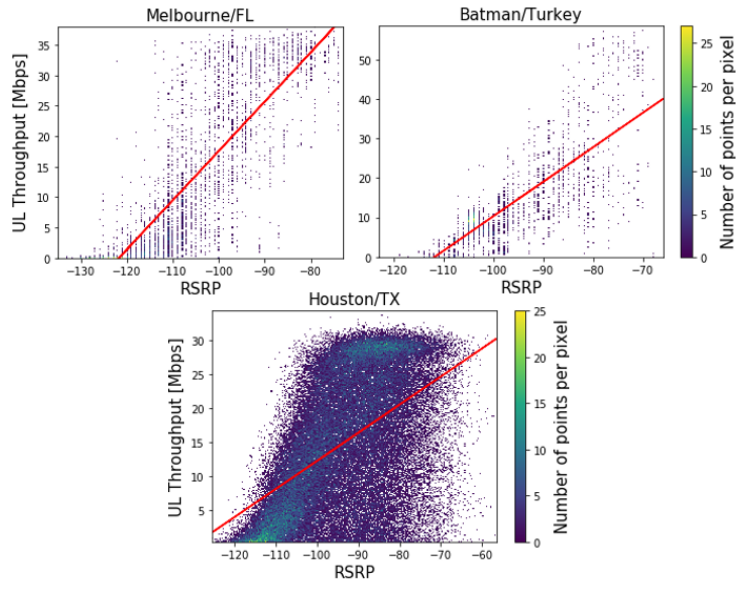
Figure 7. Scatter plot of RSRP and UL